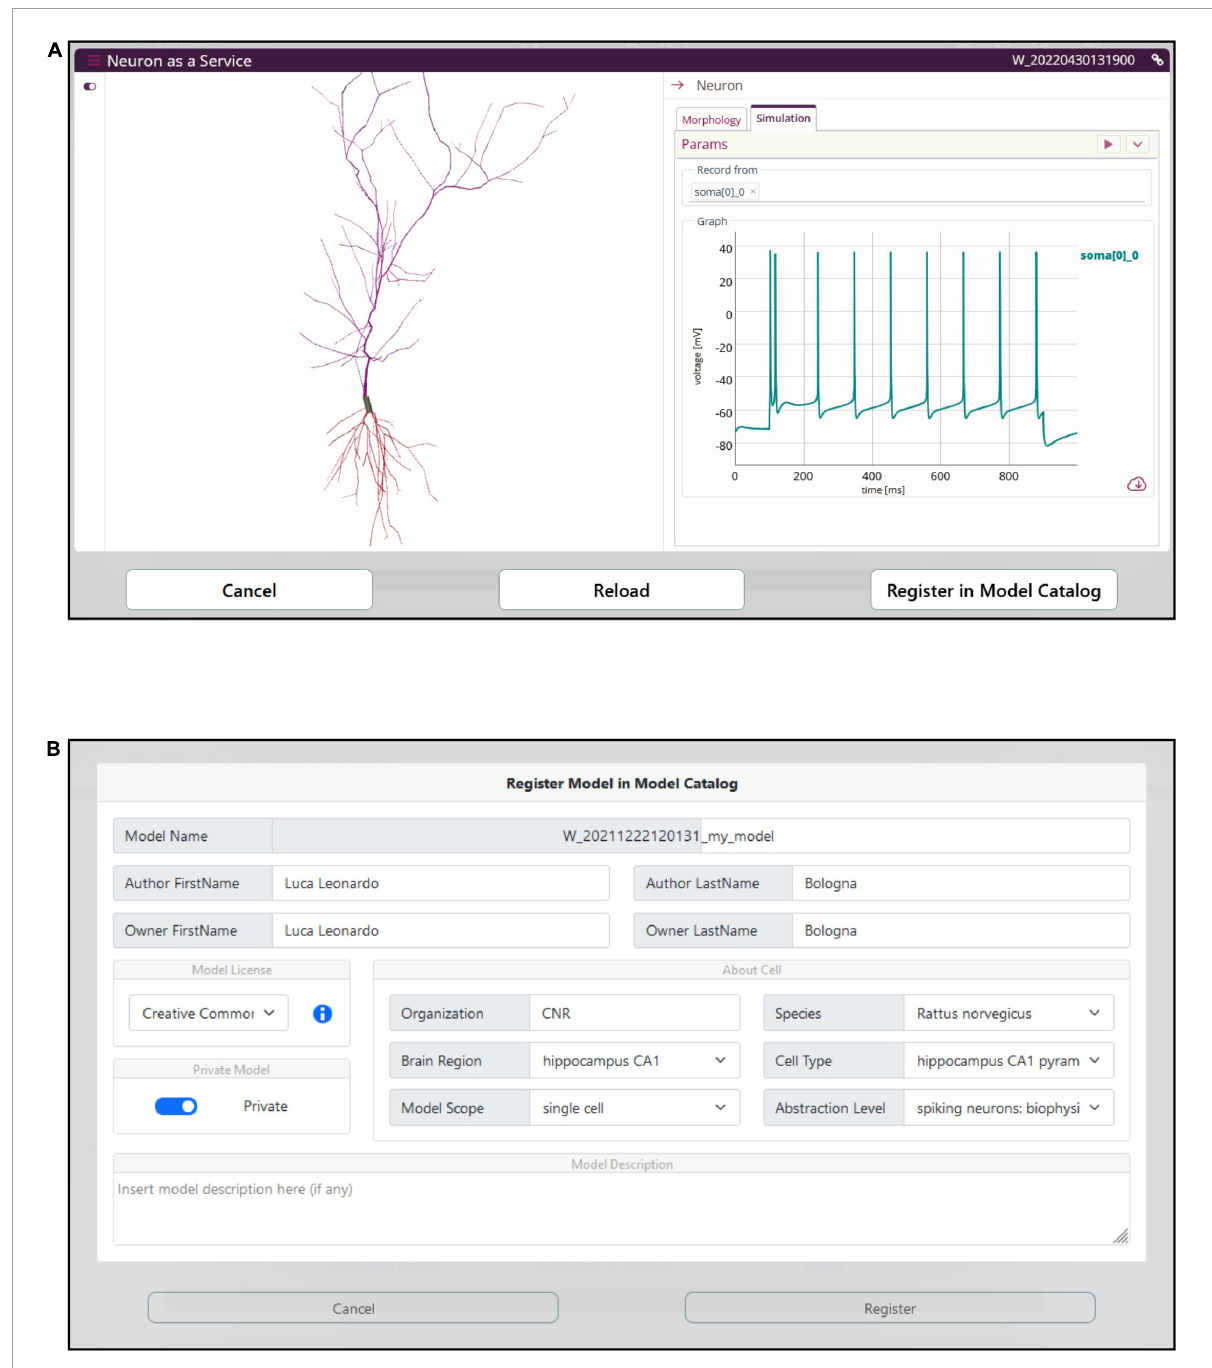
FIGURE8 Model simulation. (A) The BlueNaas web application is integrated in the HHNB in order to run a model simulation, after the model has been optimized and fetched from the HPC. The GUI allows to set the simulation and stimulation parameters, visualize the cell morphology both in 3D and as a dendrogram, select the recording compartment, visualize the simulated activity, and download the membrane potential value (recorded over the entire simulation) as a . csv file. (B) A dedicated panel for metadata specification is provided to the users in case they want to register the optimized model in the EBRAINS model